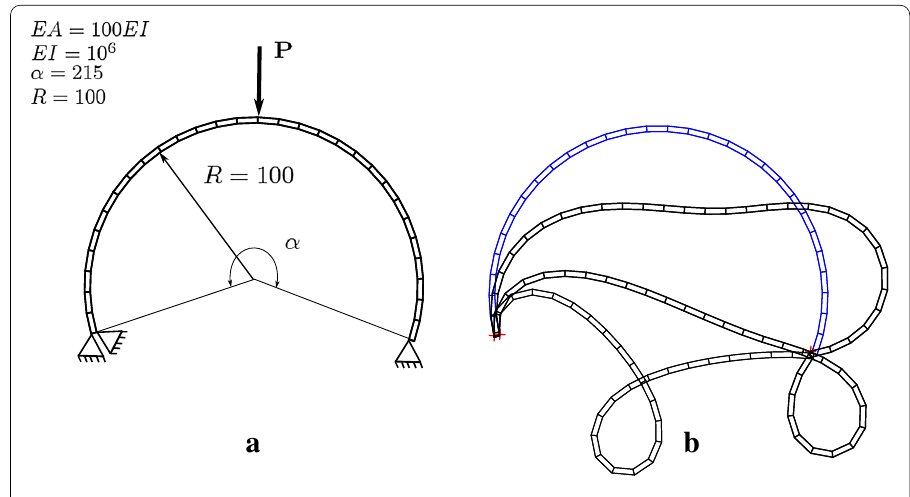
Fig. 3 Finite element mesh of a clamped-hinged circular arch: a initial shape, b deformed shape